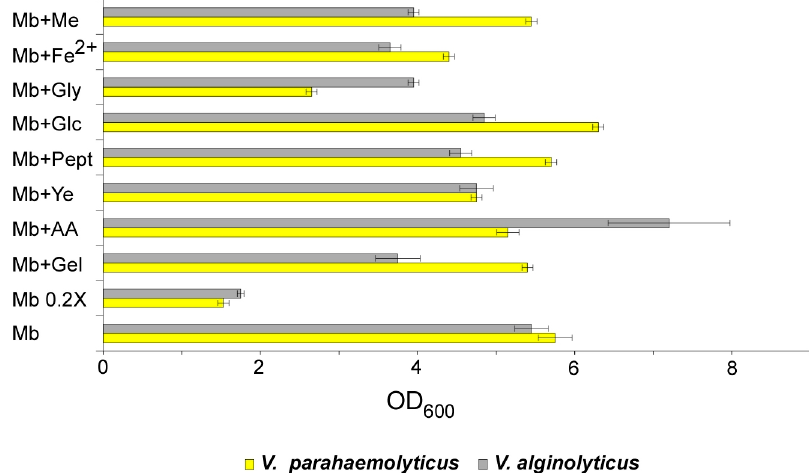
Figure 1. Growth performances of V. parahaemolyticus and V. alginolyticus in different culture media. V. parahaemolyticus and V. alginolyticus were grown overnight in the specified liquid media, and the cells density was measured spectrophotometrically as OD 600 . Mb: Marine broth; Gel: Gelatine; AA: Casaminoacids; Ye: Yeast extract; Pept: Peptone; Glc: Glucose; Gly: Glycerol; Fe: FeCl 2 .EDTA; Me: Meat extract.